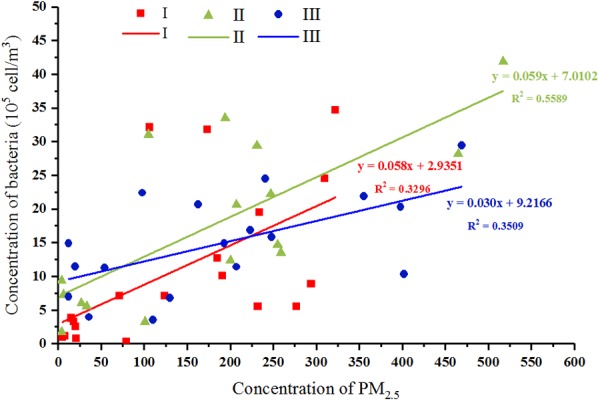
Correlations between bacterial concentration and PM2.5 mass concentration at three stages, respectively. Red, green, and blue represent samples collected from stages I, II, and III, respectively. The linear model between Cab and PM2.5 index were shown.